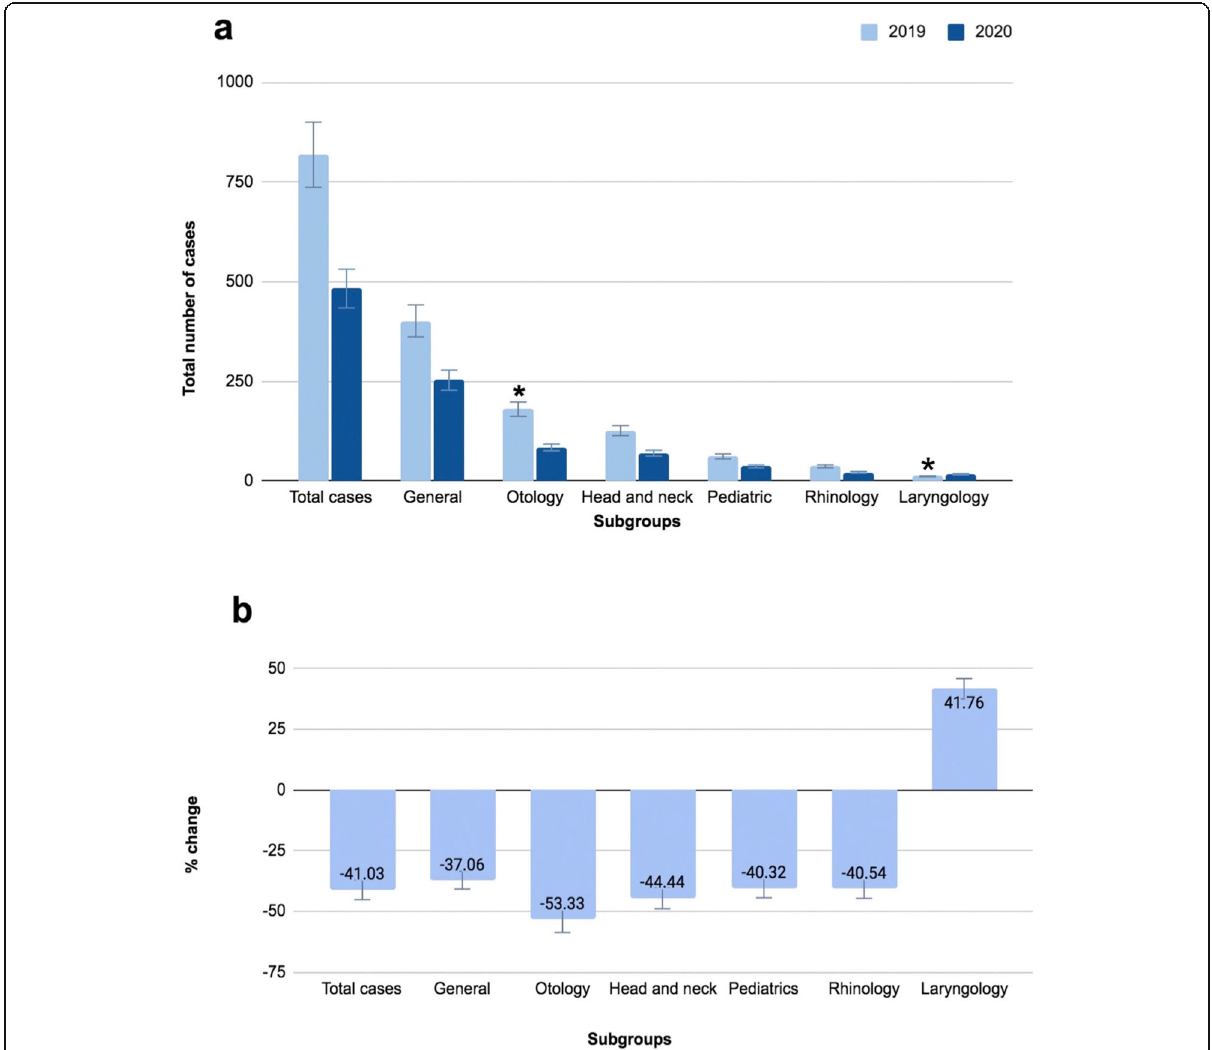
Fig. 1 Comparison of the total number of outpatient visits between 2019 and 2020 in each subgroup: a total number of outpatient visits in each subgroup; b change in the percentage of visits * p < 0.05 (chi-square test)